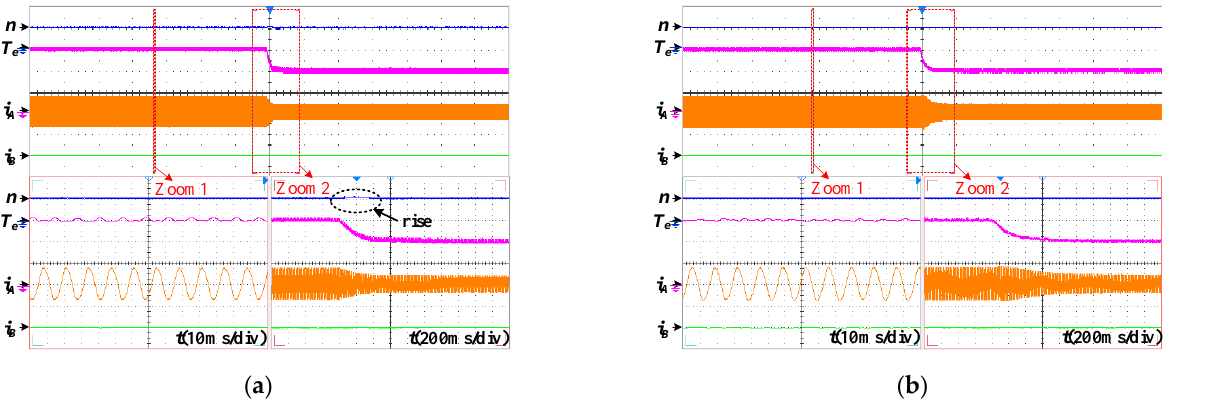
Figure 9. Dynamic responses with the reduced load at phase-A open-circuit fault-tolerant operation. (500 rpm/div, 2 Nm/div, 5 A/div). ( a ) Conventional fault-tolerant FOC. ( b ) Proposed fault-tolerant FOC.